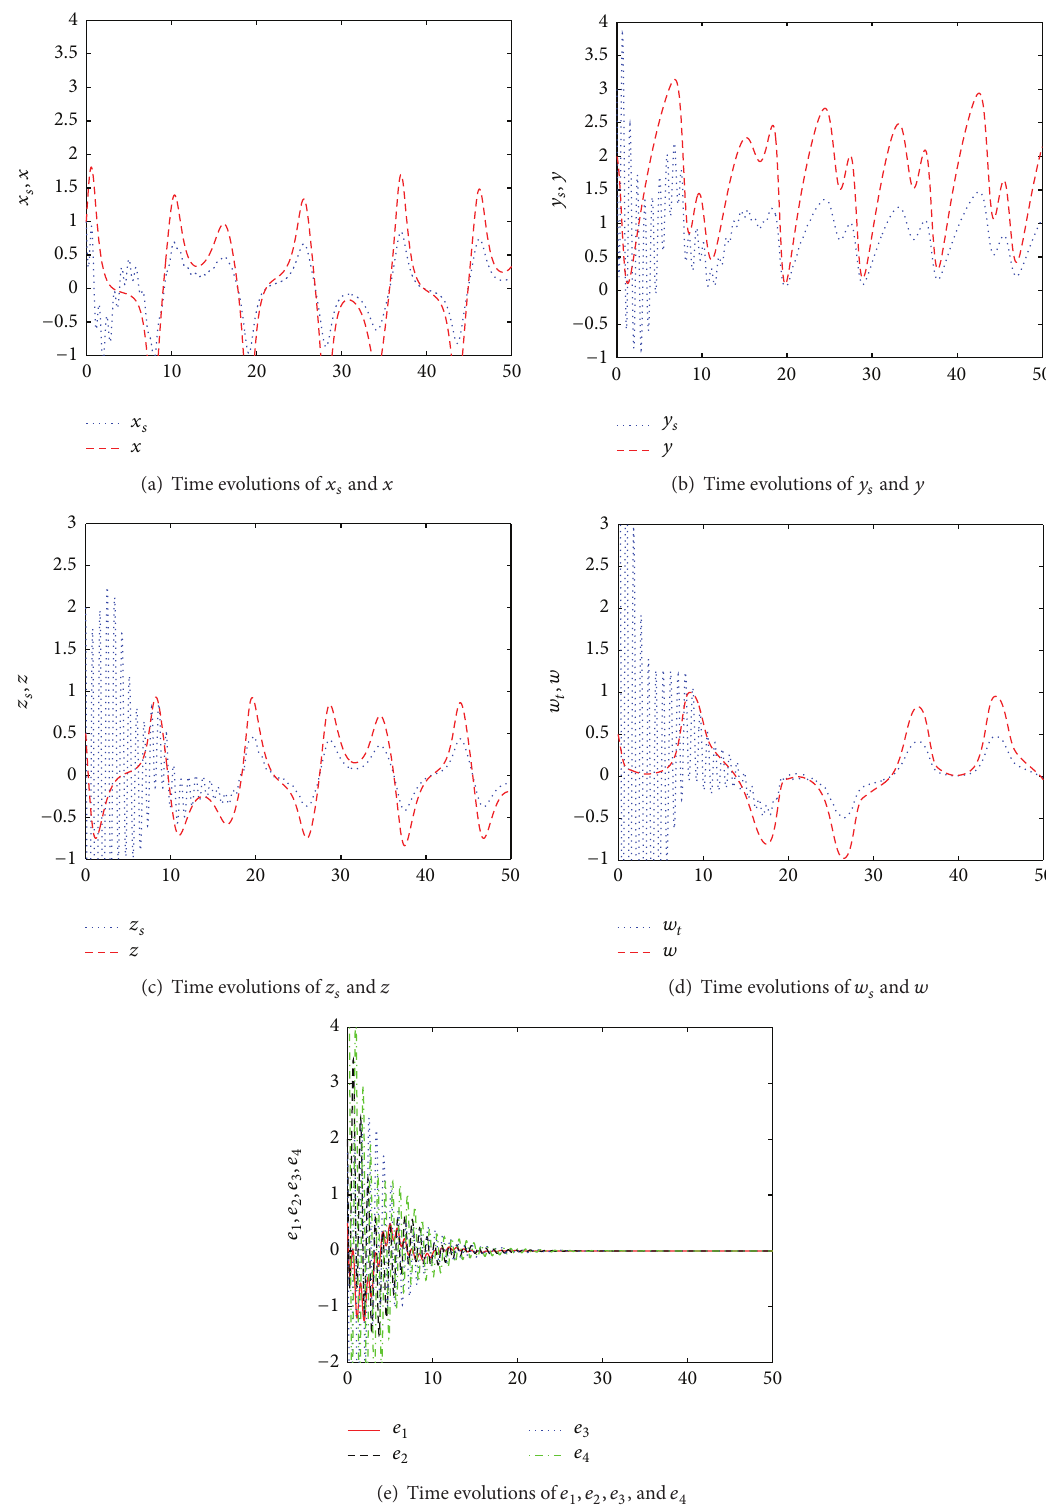
Figure 2: Time evolutions of the state variables of system